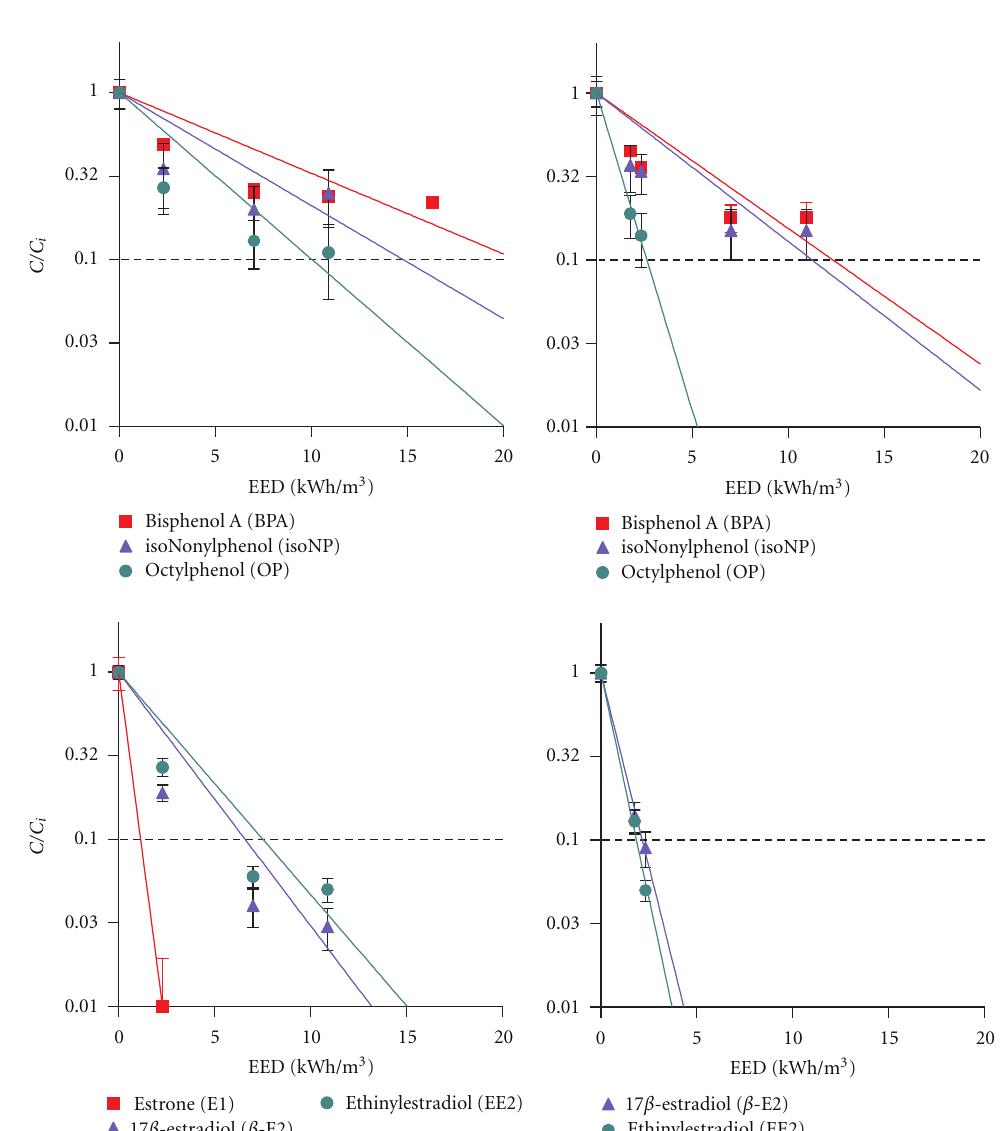
Figure 6: Degradation of selected estrogenic chemicals. Left: direct UV treatment. Right: UV/H 2 O 2 treatment with a hydrogen peroxide concentration of